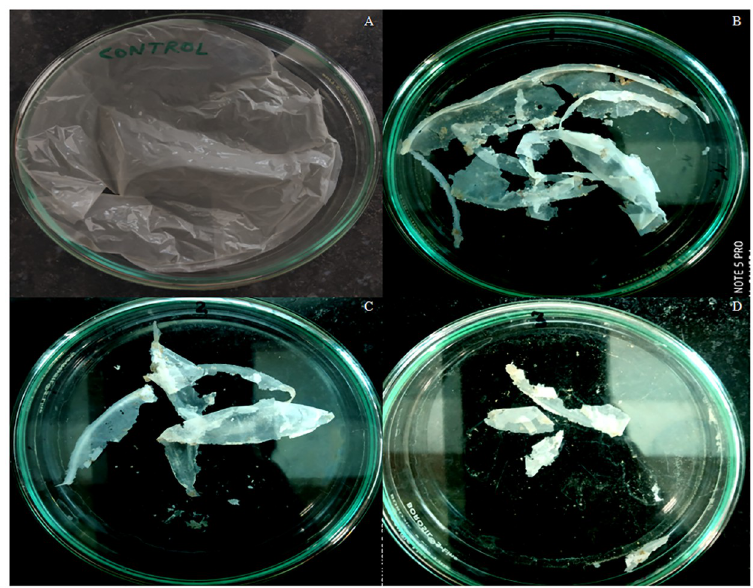
Fig 3. Degradation of PHB film treated with (A) control and Aeromonas caviae Kuk1-(34) sp. after (B) 15 days (C) 30 days and (D) 45 daysin soil burial method.